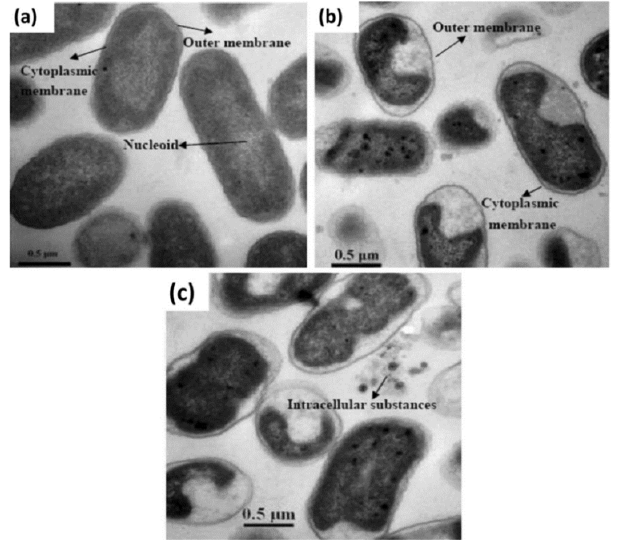
Figure 10. TEM images of ( a ) untreated E. coli cells, ( b ) treated with ZnO nanoparticles, and ( c ) treated with Zn 2+ ions solution in ultrapure water. Reprinted/adapted with permission from Ref. [31]. Copyright © 2022, American Chemical